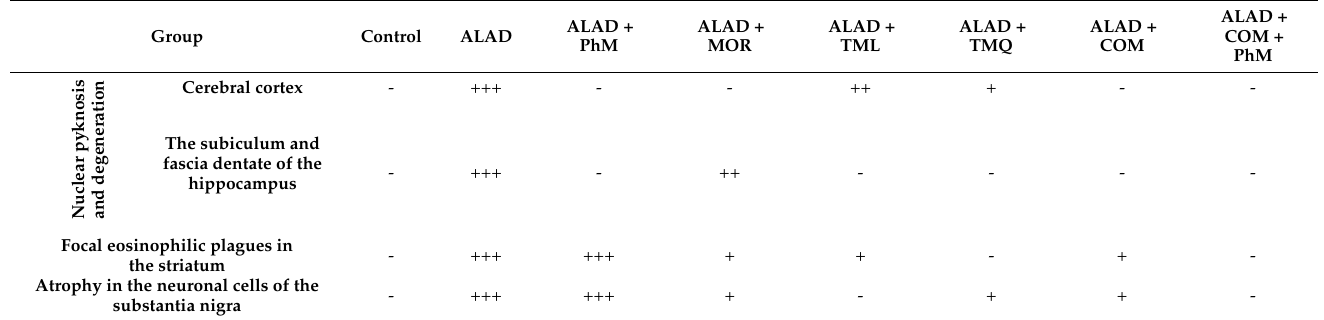
Table 1. The histopathological score for the cerebral cortex and hippocampus. The severity of histopathological alterations in rat brain areas is indicated in different experimental groups.